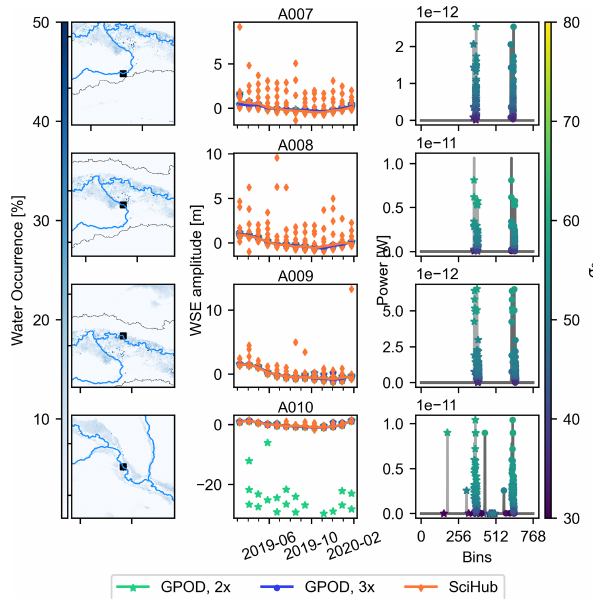
Figure 8. Water surface elevation (WSE) time series in the upper Zambezi and GPOD waveforms after the OLTC update at four vir- tual stations (VSs). The columns show the VS location (left), the WSE time series from March 2019 to January 2020 (middle) and the waveforms (right). For clarity, we only show the GPOD wave- forms as the conclusions are not affected by the Level-1b process- ing in any of these cases. Due to the window extension and padding of the Hamming window on GPOD, the waveforms are shifted by 256 and 512 bins for the double and triple extensions,